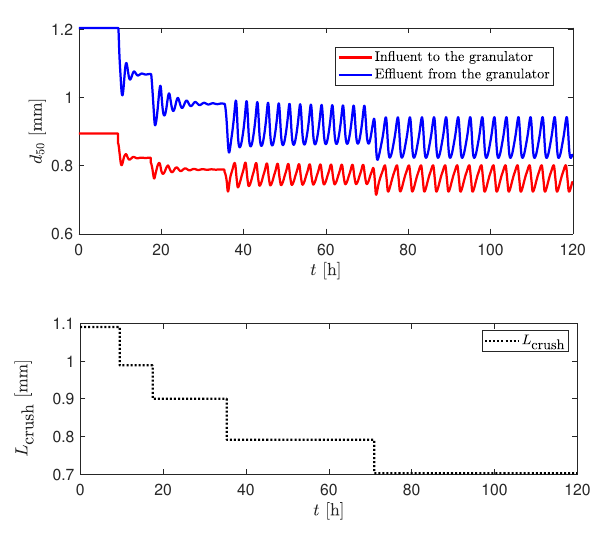
Figure 14: d 50 as a response to the step-by step change of L crush with ˙ m slurry = 500